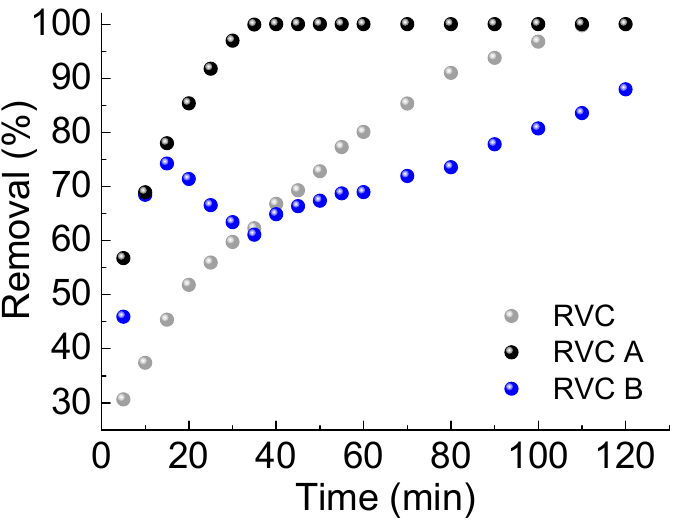
Figure 5. Efficiency in the discolouration of a 20 mg L − 1 MB solution by electrofenton, with applied currents of 100 mA.